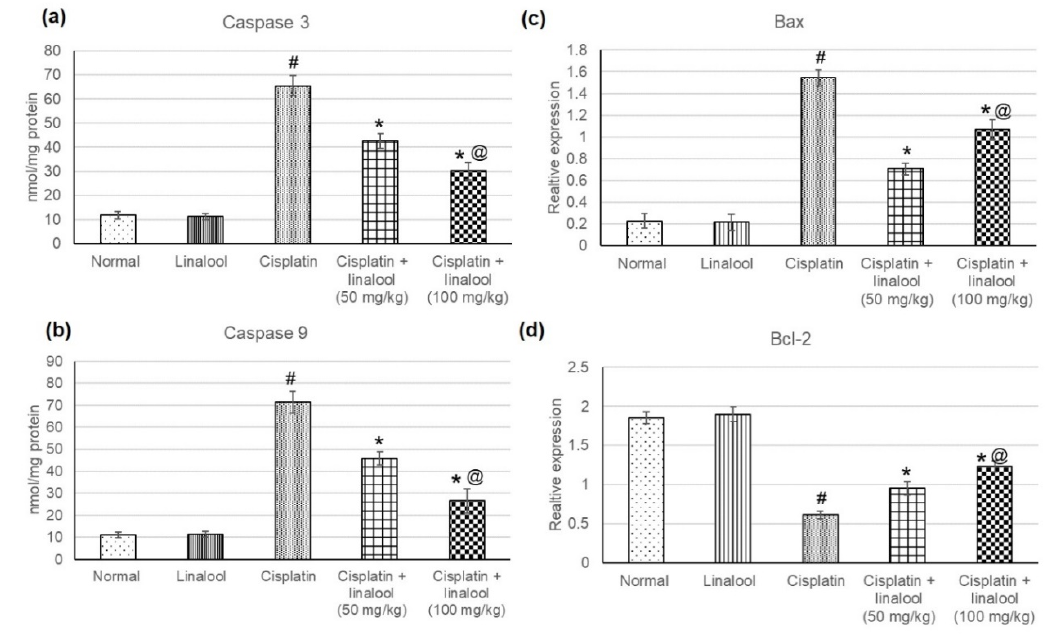
Figure 5. Effects of pre-treatment with linalool (50 and 100 mg/kg) on the apoptotic markers: ( a ) Caspase 3, ( b ) Caspase 9, ( c ) Bax, and ( d ) Bcl2 levels in cisplatin-induced acute kidney injury. All values are expressed as mean ± SD. # indicates statistically significant from the normal control group, * denotes statistically significant from the cisplatin-only group, and @ indicates statistically significant from cisplatin + linalool 50 mg/kg group ( p < 0.05) using one-way ANOVA followed by Tukey’s post-hoc test.